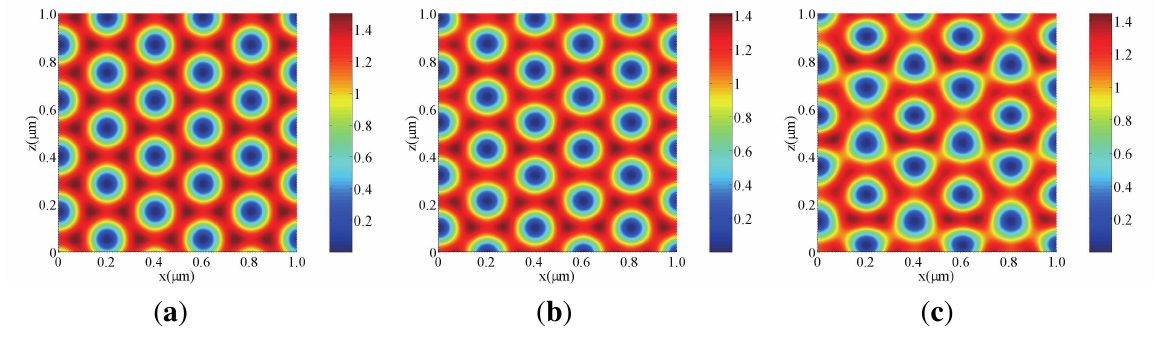
Figure 4. Calculated intensity distributions under p-polarized three-beam interference holographic exposure at a wavelength of 532 nm ( a ) in the free space and in the HPDLC film ( b ) without and ( c ) with ITO